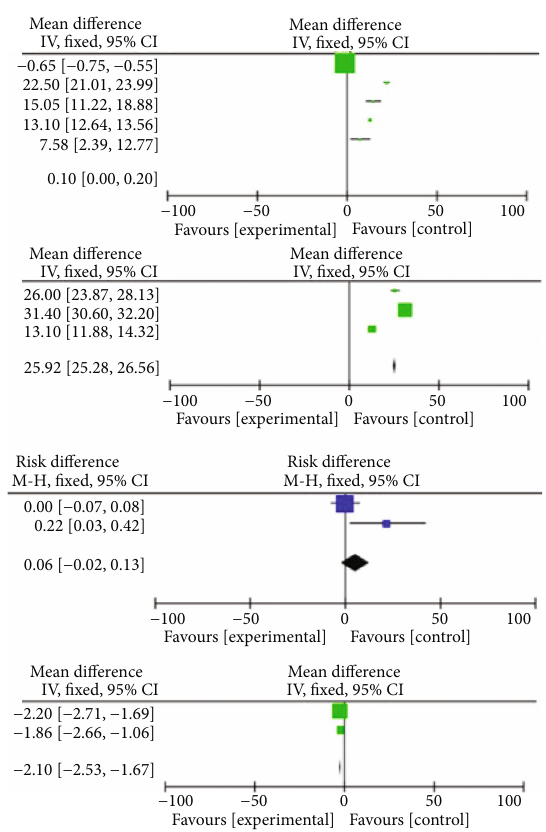
Figure 5: The mean di ff erence of electroacupuncture on BI, Fugl-Meyer index, CSS, and NIHSS of cerebral